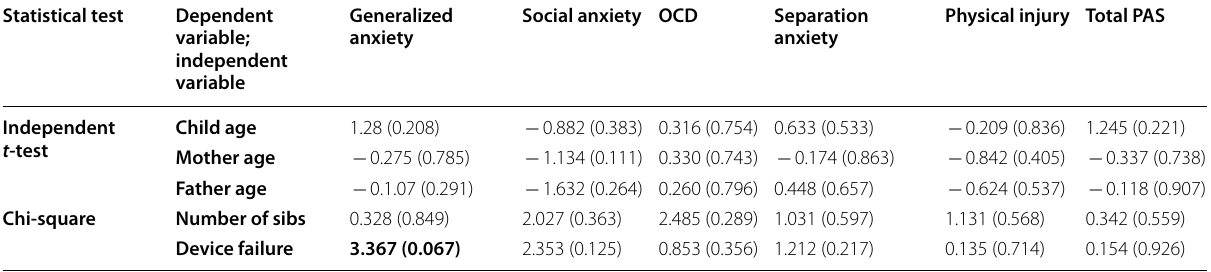
Table 2 Comparing the means of positive and negative subgroup scores on the PAS total scale and its subscales across different independent variables (child age, maternal age, father age) using independent samples t -test, as well as comparing the distribution of positive and negative subgroup scores on PAS total scale and its subscales as regards categorical independent variables (number of sibs, device failure) using chi-square for